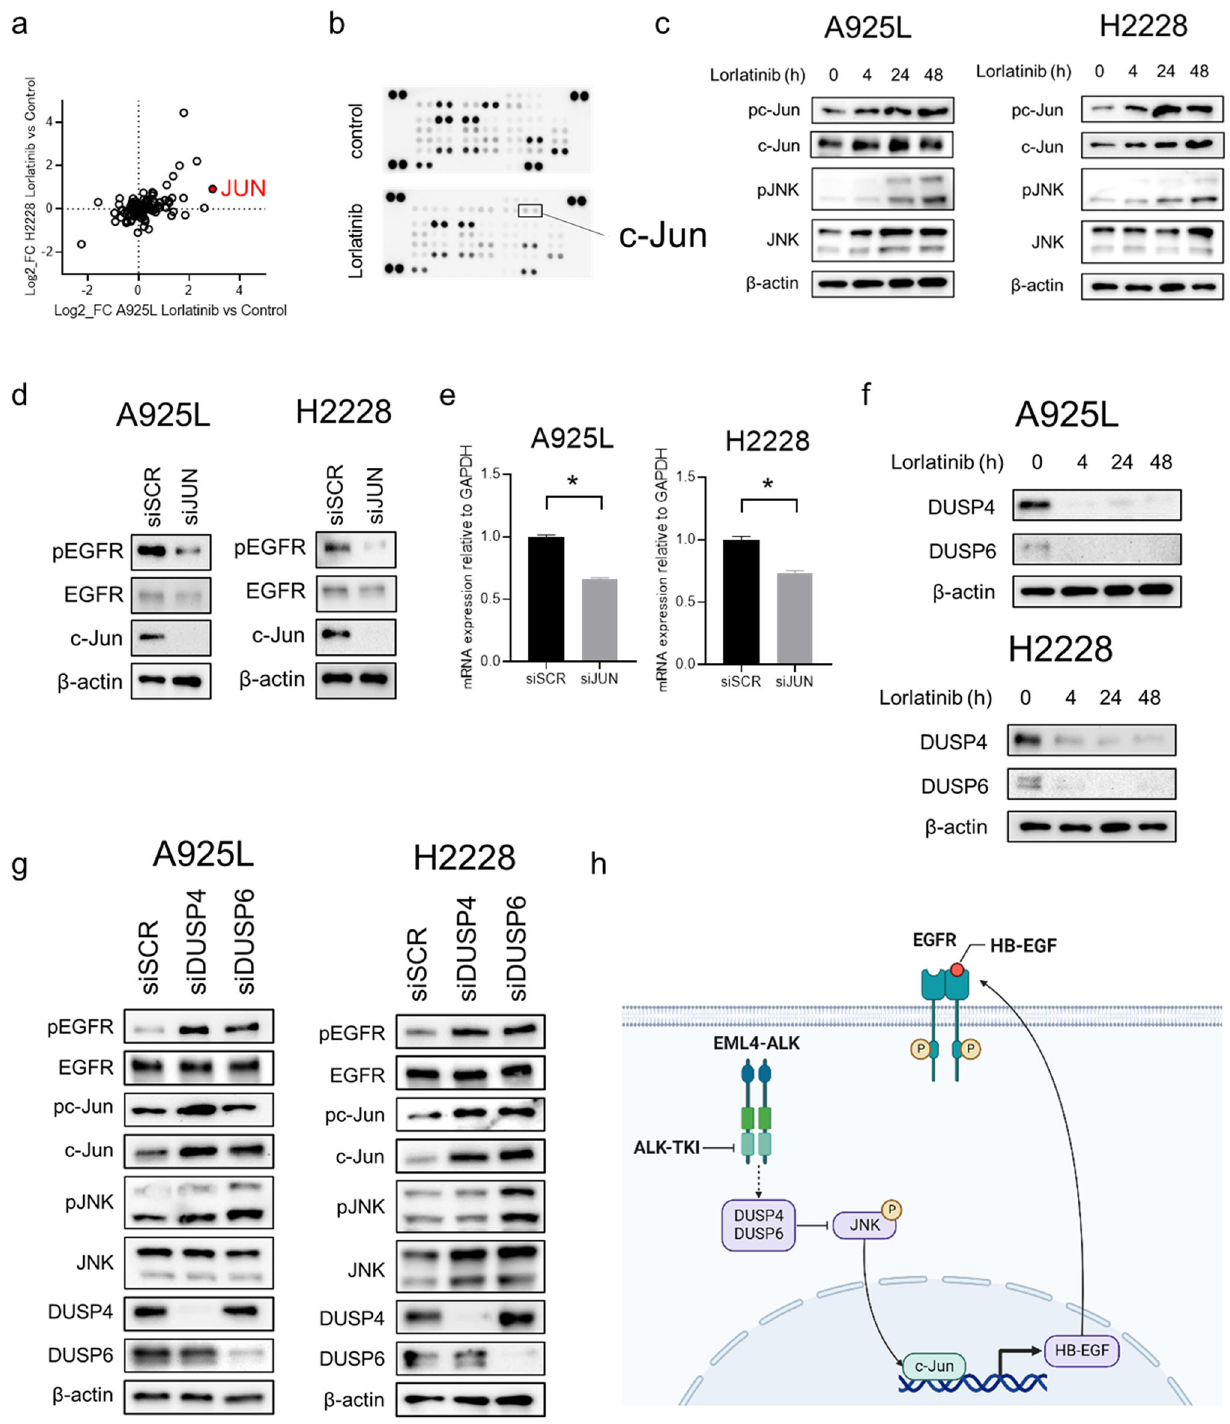
Fig. 3 EGFR activation is induced by JNK/c-Jun axis activation via suppression of DUSP4 and DUSP6. a Scatterplot of genes in the KEGG_ERBB_SIGNALING_PATHWAY gene set in either A925L or H2228 DT cells vs. that in parent cells. b Human phospho-kinase array analysis of parental A925L and H2228 cells, as well as cells treated with lorlatinib (100 nmol/L) for 48 h. c Western blotting of A925L and H2228 cells treated with lorlatinib (100 nmol/L) for the indicated durations. d A925L and H2228 cells were incubated with nonspeci fi c control siRNA or JUN -speci fi c siRNA and lysed, and the indicated proteins were detected using western blotting. e qPCR of heparin-binding EGF-like growth factor (HB-EGF) in parent A925L and H2228 cells and cells incubated with nonspeci fi c control siRNA or JUN -speci fi c siRNA. * P < 0.01 (unpaired t -tests). f Western blotting of A925L and H2228 cells treated with lorlatinib (100 nmol/L) for the indicated durations. g A925L and H2228 cells were incubated with nonspeci fi c control siRNA and DUSP4 or DUSP6-speci fi c siRNA and lysed, and the indicated proteins were detected using western blotting. h Schematic diagram showing the mechanisms of adaptive resistance, including activation of EGFR signaling via endogenous HB-EGF stimulation, the feedback loop of which was induced by the JNK/c-Jun axis, in ALK-rearranged NSCLC cells. Data are represented as mean ±